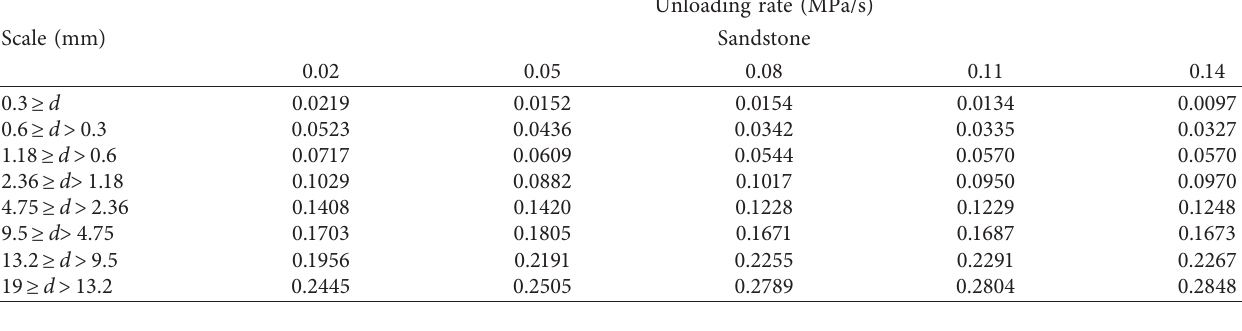
Table 7: Mass fractions of fragments at different scales in the sandstone sample under different unloading rates.